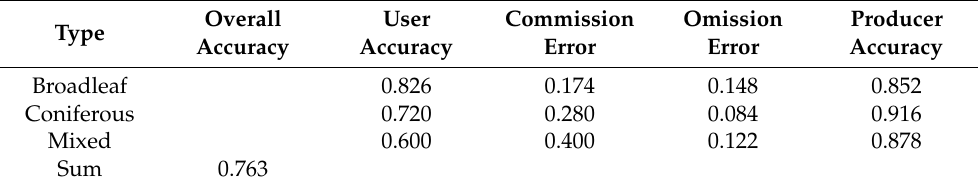
Table 10. Accuracy evaluation matrix of integration results based on Model II.